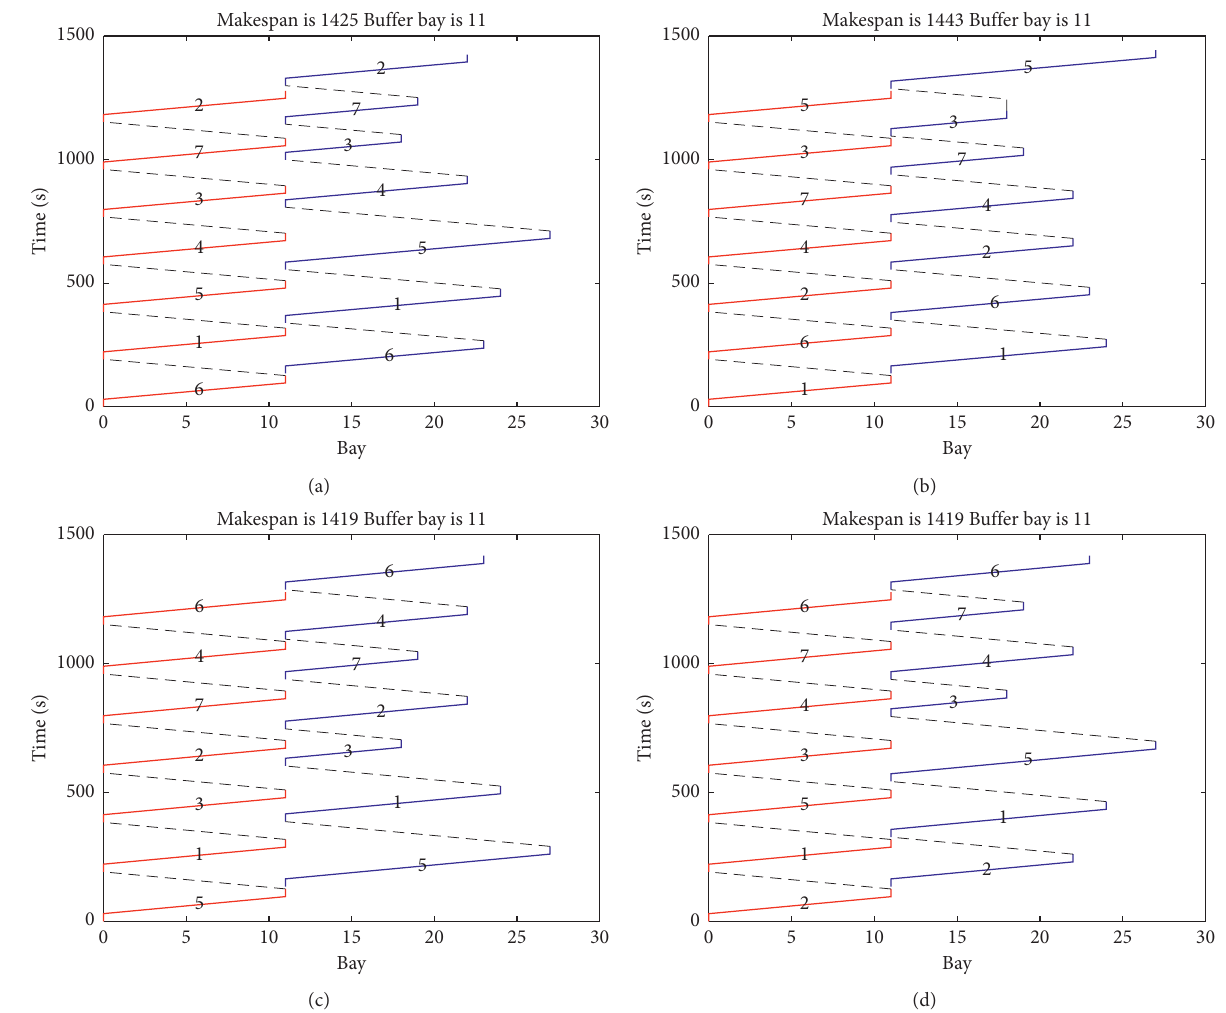
Figure 6: Time-space diagrams of seven tasks scheduled by the proposed methods. (a) Crane priority-based GA. (b) Greedy insert. (c) MILP. (d) Task priority-based GA.